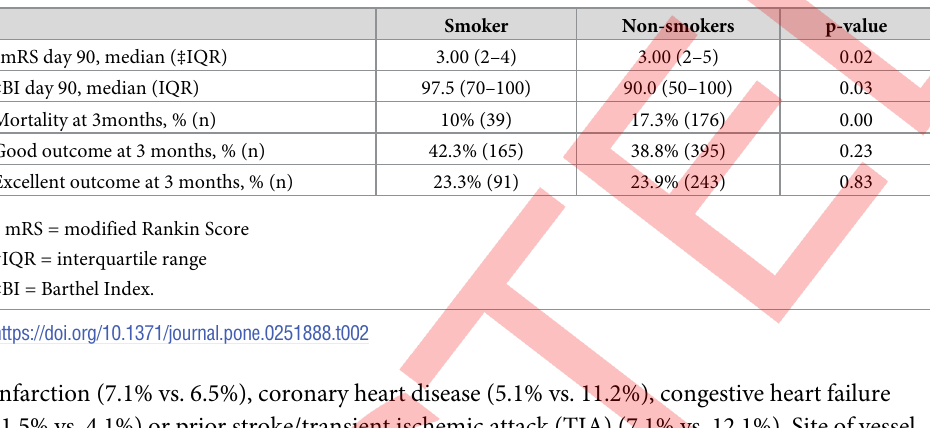
Table 2. Univariate analysis of primary outcome endpoints based on smoking